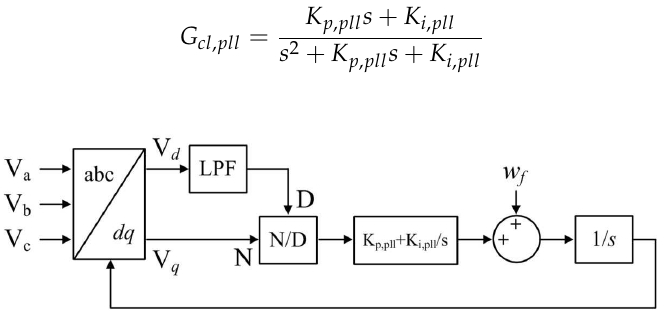
Figure 2. Control block diagram of the synchronous reference frame phase-locked loop (PLL).